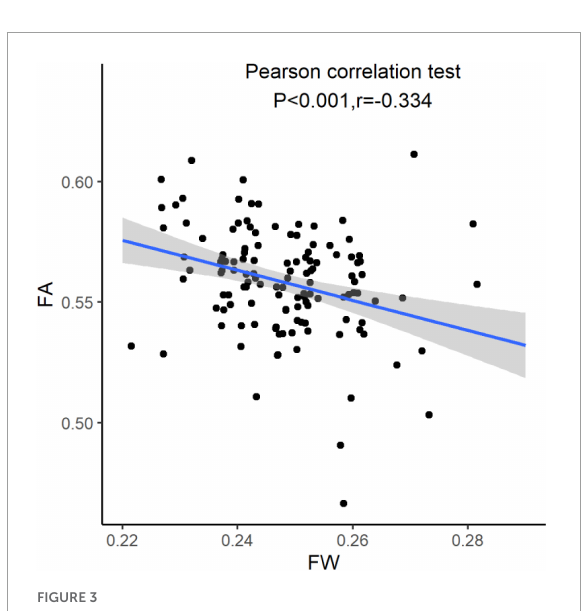
FIGURE3 Relationship between extracellular fluid of white matter and fraction anisotropy. FW, free water; FA, fractional anisotropy.